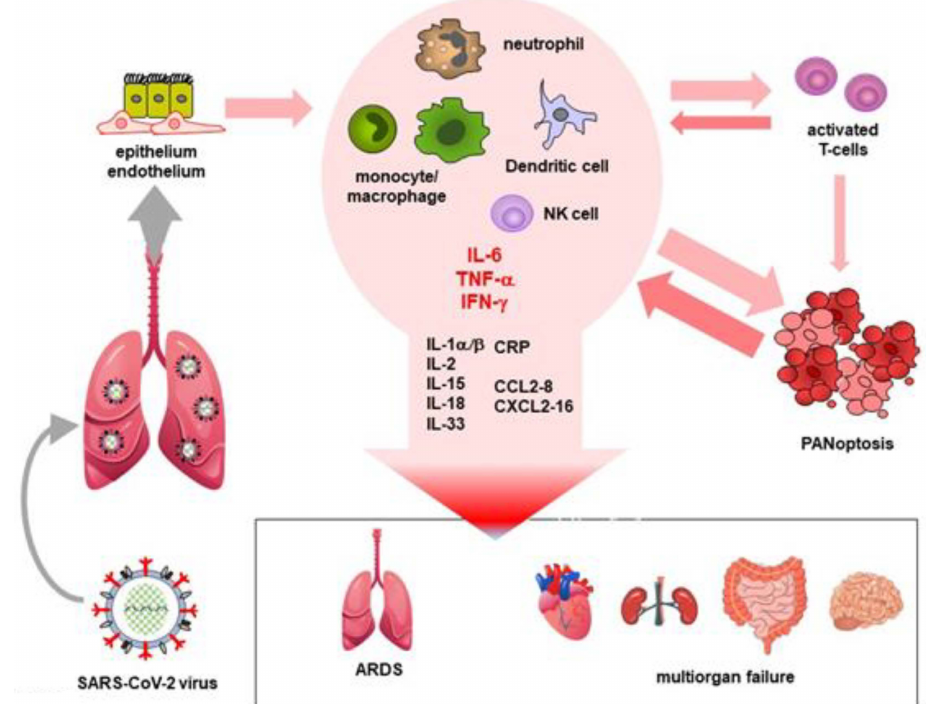
Figure 3. Development of cytokine storm and multiorgan involvement in